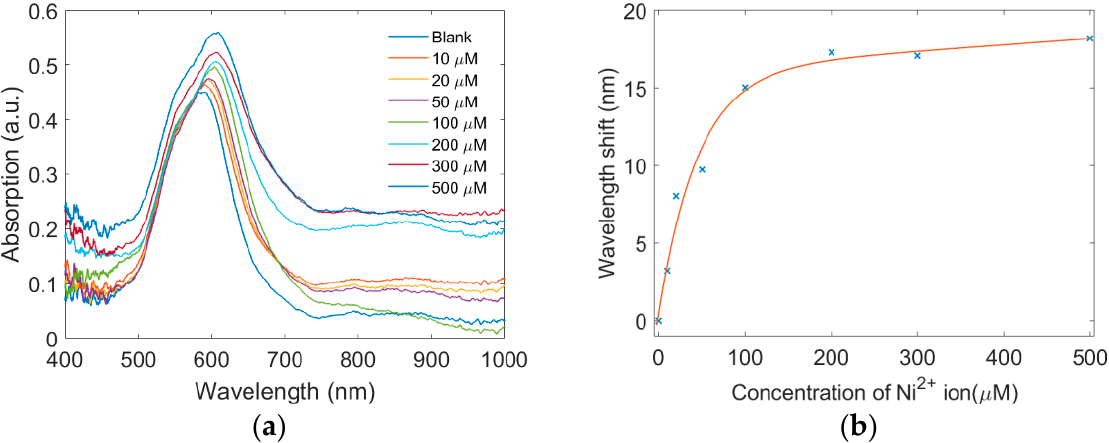
Figure 7. Ni 2+ sensing based on the proposed LSPR sensor. ( a ) Absorption spectra with different concentrations of Ni 2+ ions. ( b ) Wavelength shift as a function of the concentration of Ni 2+ ions.